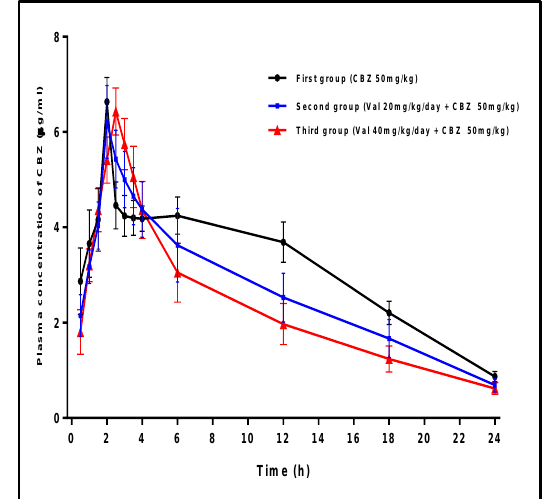
Figure 1. Concentration -time profile of CBZ without VAL (First group) and with VAL (Second and third groups) in rabbits.